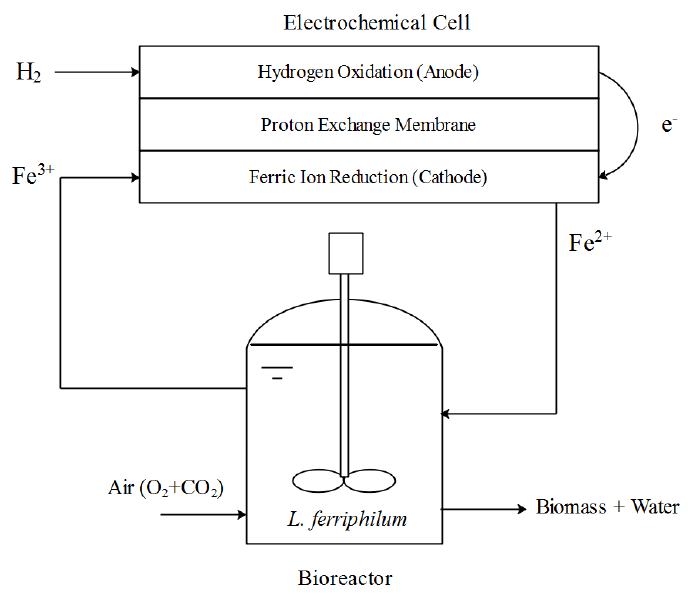
Figure 1. Schematics of the BioGenerator.